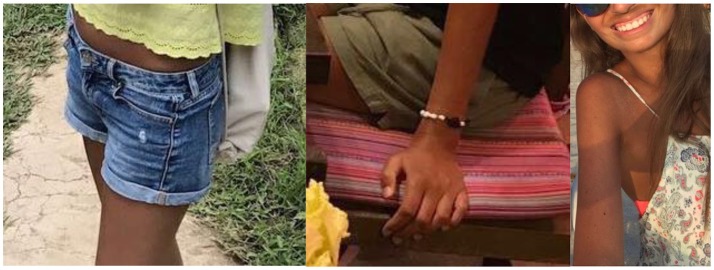
Hyperpigmentation and skinny figure due to Addison's disease.